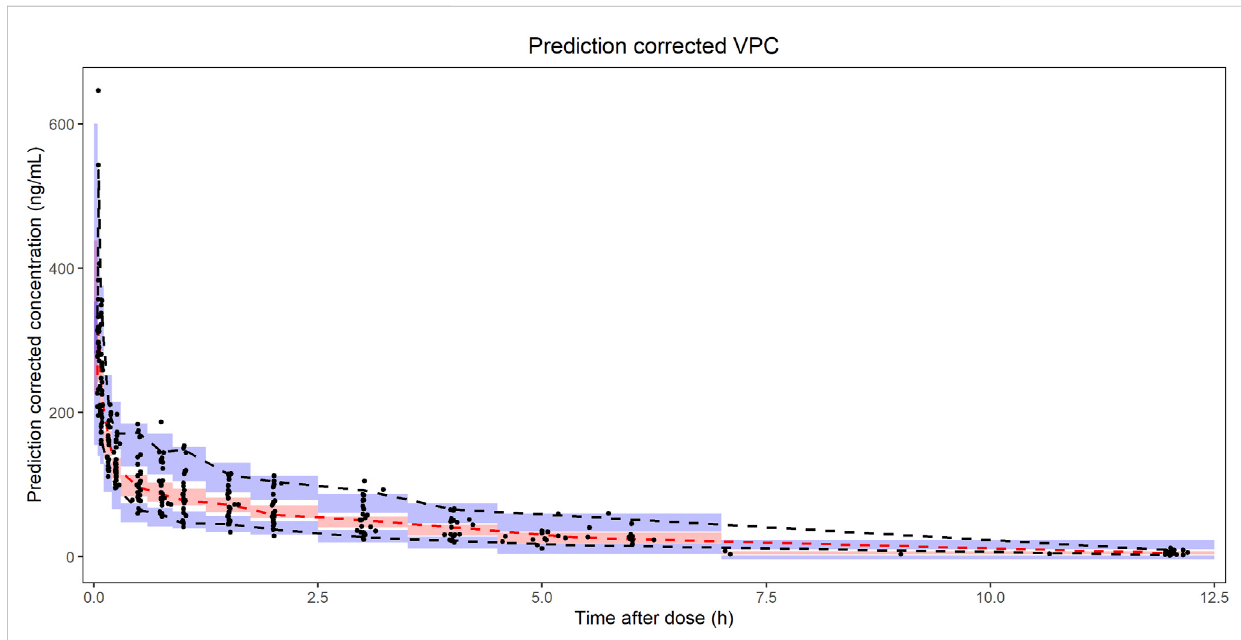
FIGURE 5 Prediction corrected visual predictive checks (pc-VPC) of nalbuphine fi nal PopPK model. The black dots represented prediction corrected observations. The black dashed lines represented 90% interval of the prediction corrected observations. The red dashed lines represented median of the prediction corrected observations. The red shaded area represented 95% con fi dence interval (CI) of the median prediction. The blue shaded area represented 95% CI of the 5th and 95th prediction interval.